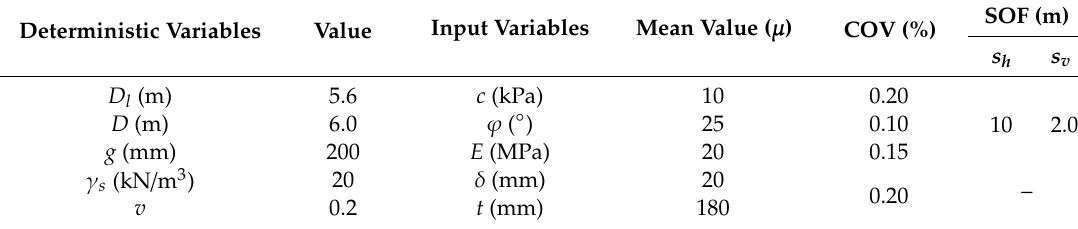
Figure 4. Model geometry and mesh gird. Table 2. Input parameters for the reference case.